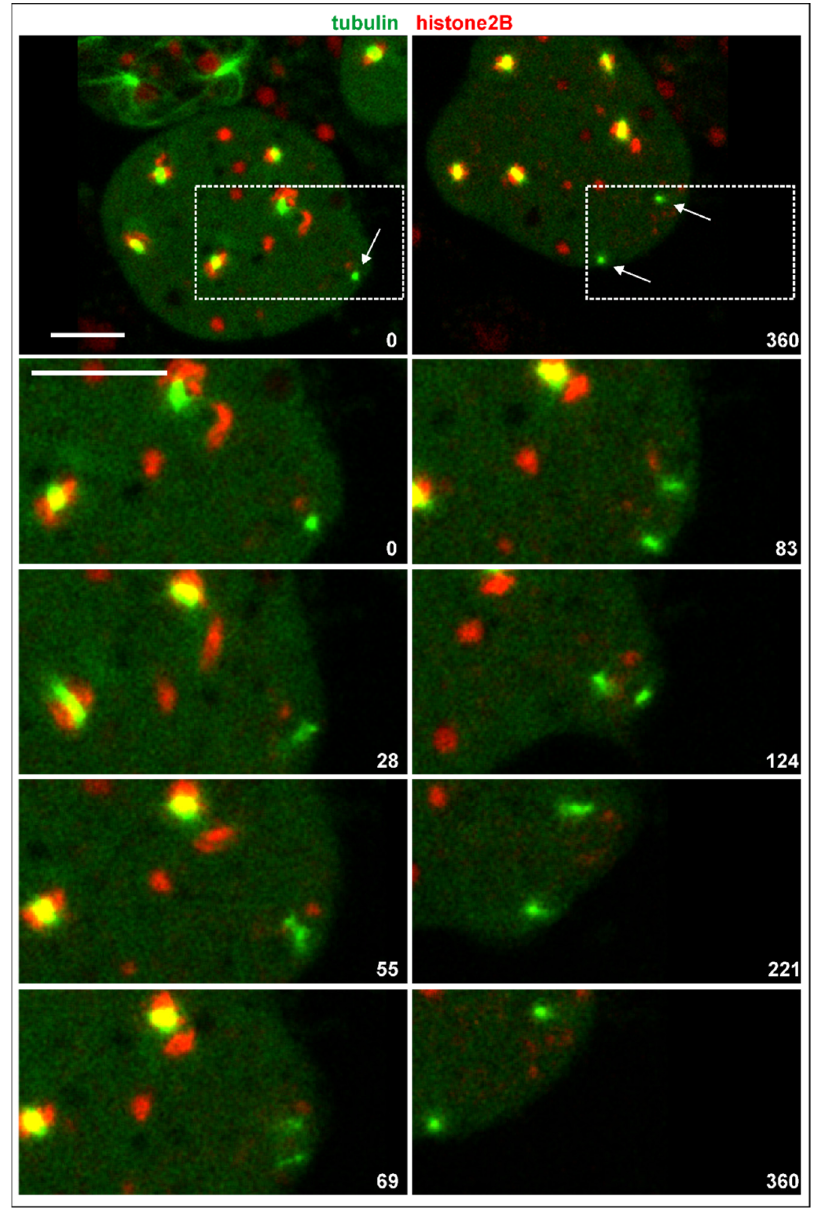
Figure 6. Division of an isolated centrosome. The RacE-null cell expressed GFP- α -tubulin to label the mitotic apparatus including the centrosomes (green) and mRFP-histone2B (chromatin structures red). The two upper panels show the entire cell at the beginning and 6 min period. Division of a centrosome is indicated by arrows. The boxed area is magnified in the lower panels to highlight division of the single centrosome with no spindle being formed. The cell was compressed by agar overlay. Time is indicated in seconds. Bars, 10 µ